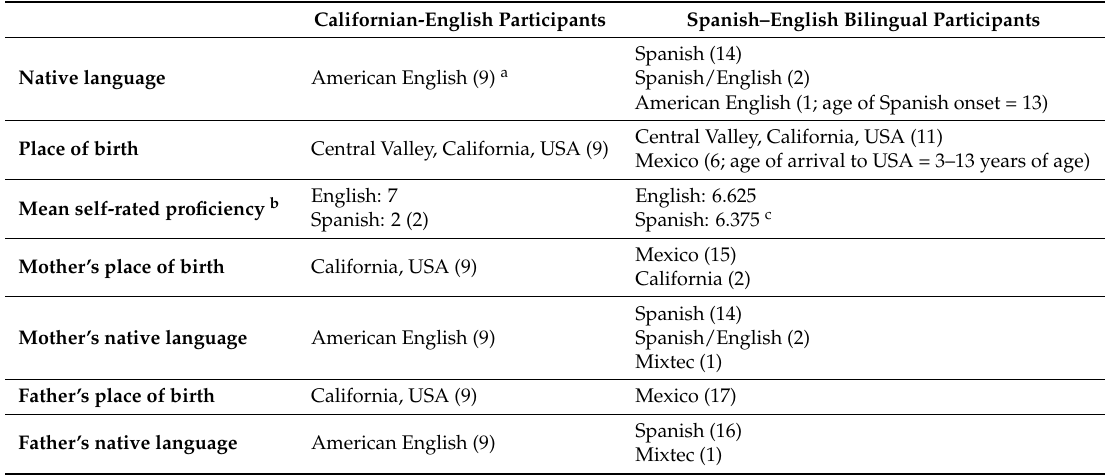
Table 1. A summary of the demographic details of our Californian English monolingual and Spanish–English bilingual